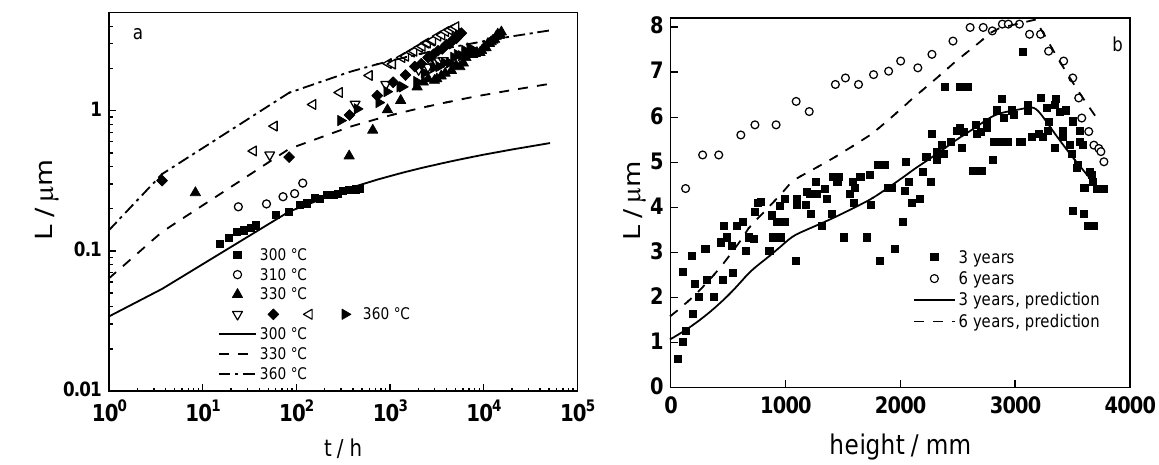
Figure 14. ( a ) Thickness of oxide layers on Zr-1%Nb as depending on temperature and time of oxidation; ( b ) Distribution of oxide thickness on Zr-1%Nb fuel cladding by fuel rod height after 3 and 6 years of service in a WWER-1000 reactor: points-experimental data from various sources, lines-model predictions.